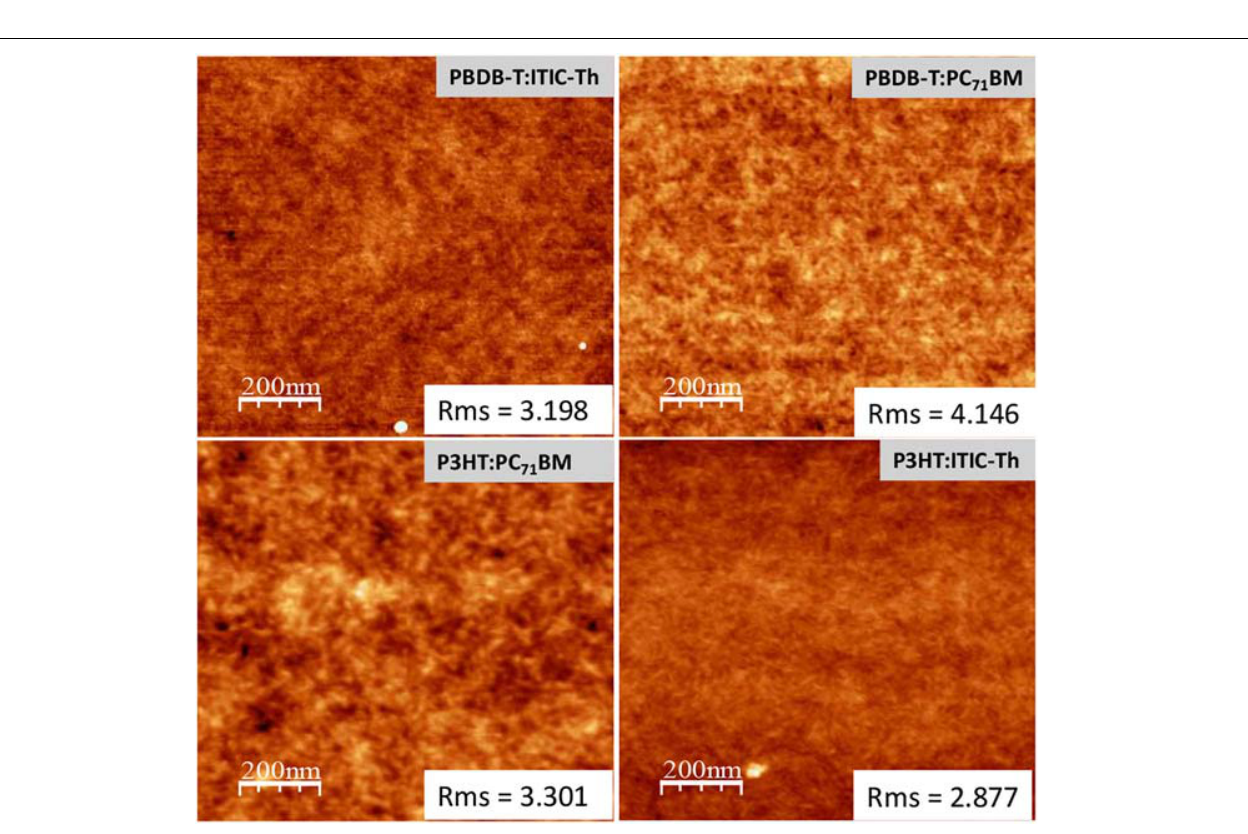
FIGURE 12 | Tapping mode AFM images measured for various thin film